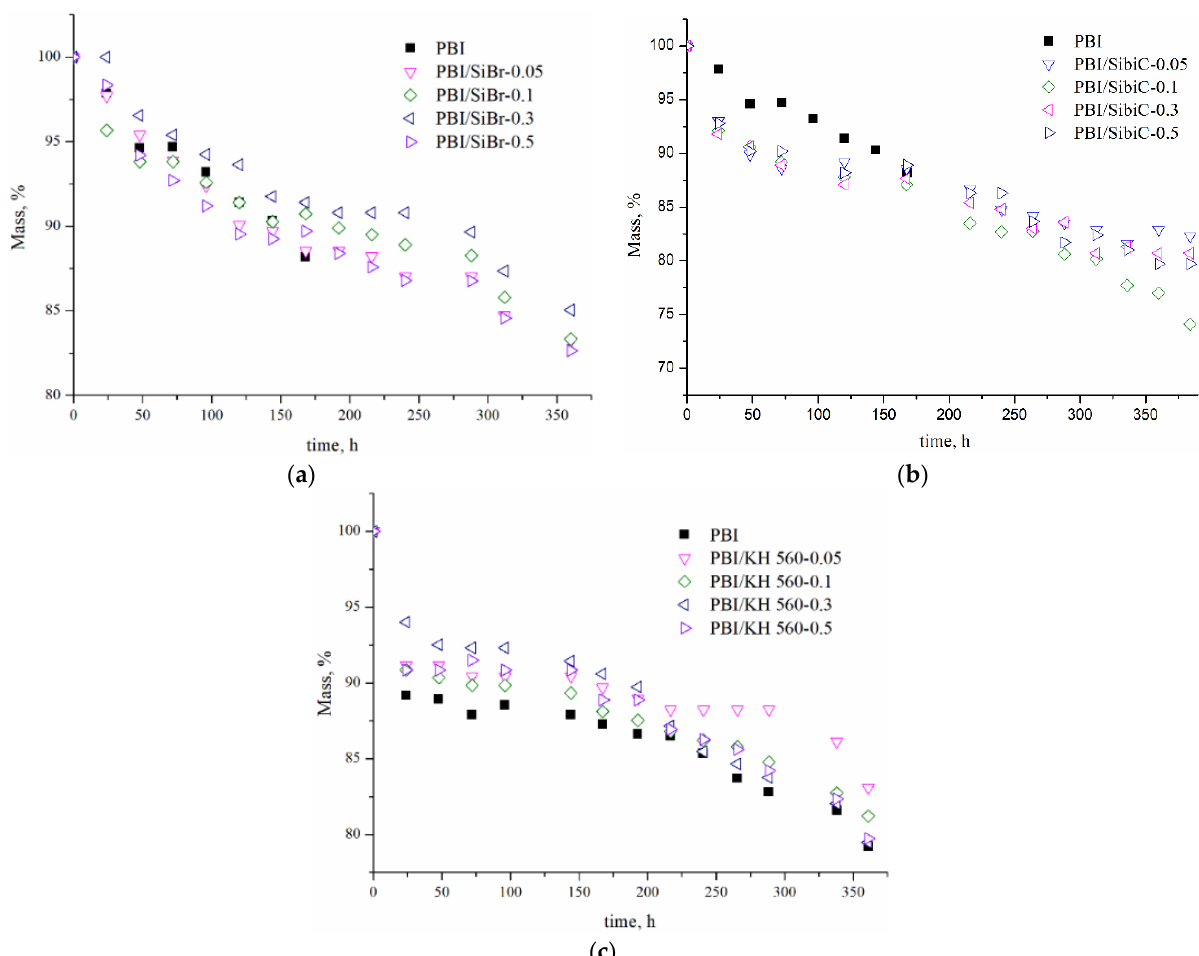
Figure 4. Results of degradation of cross-linked PBI membranes in the Fenton test. SiBr ( a ), SibiC ( b ) and KH 560 ( c ) were used as crosslinking reagents.